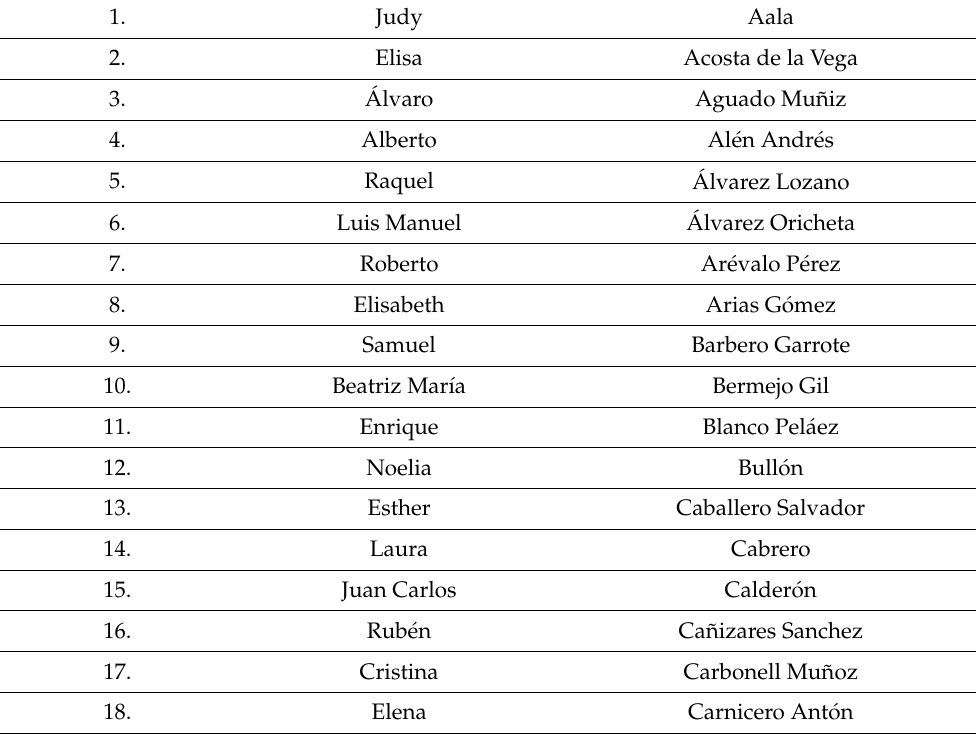
Figure S3: Seroprevalence according to the time of the serology, Table S1: Seroprevalence of IgG & IgM antibodies according to blood types and Body Mass Index